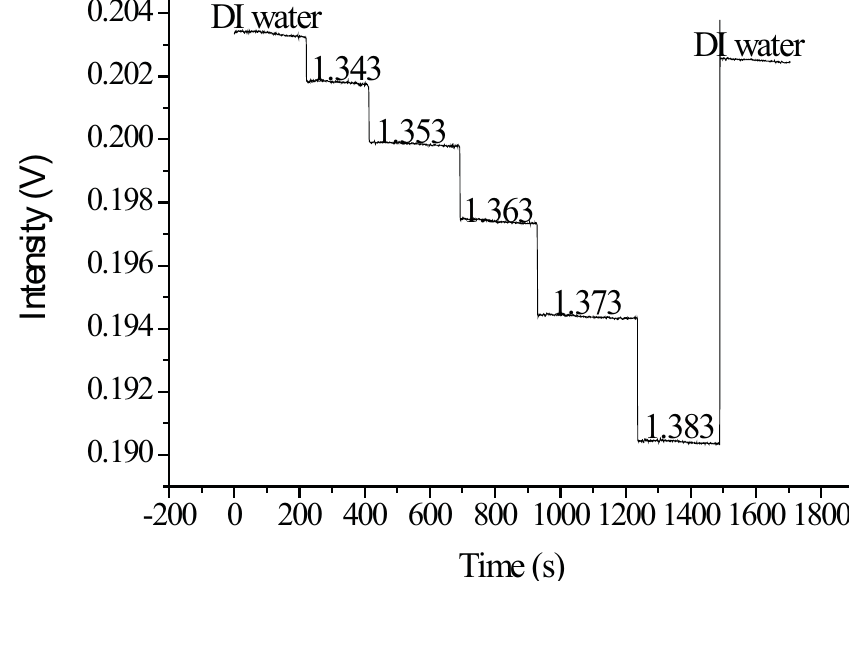
Figure 21. Plot of the ATR fiber sensors’ temporal responses to injections of increasing sucrose solution concentrations and refractive